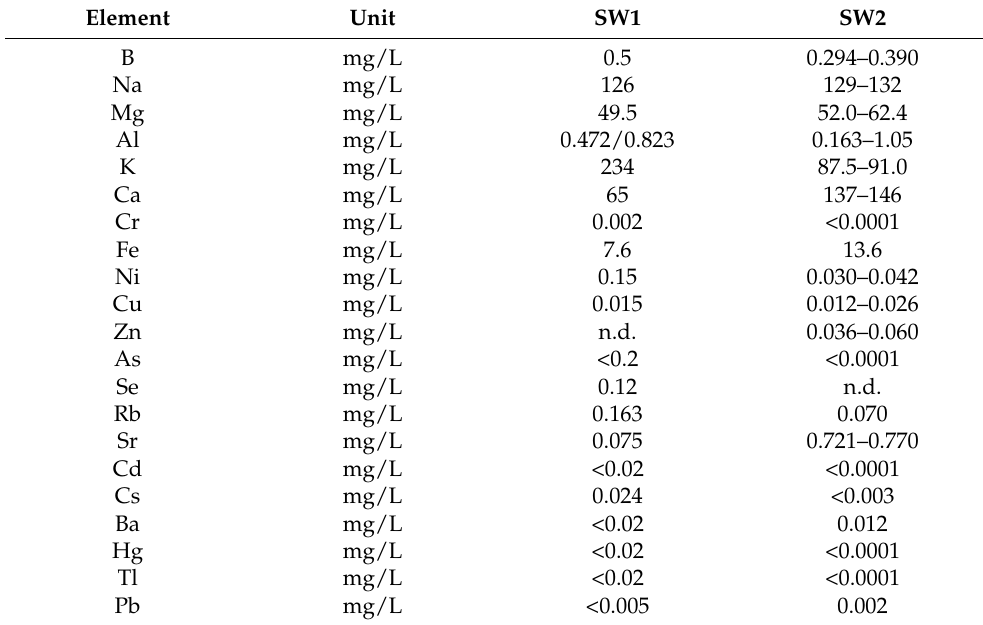
Table 2. Elementary composition of the examined slugde